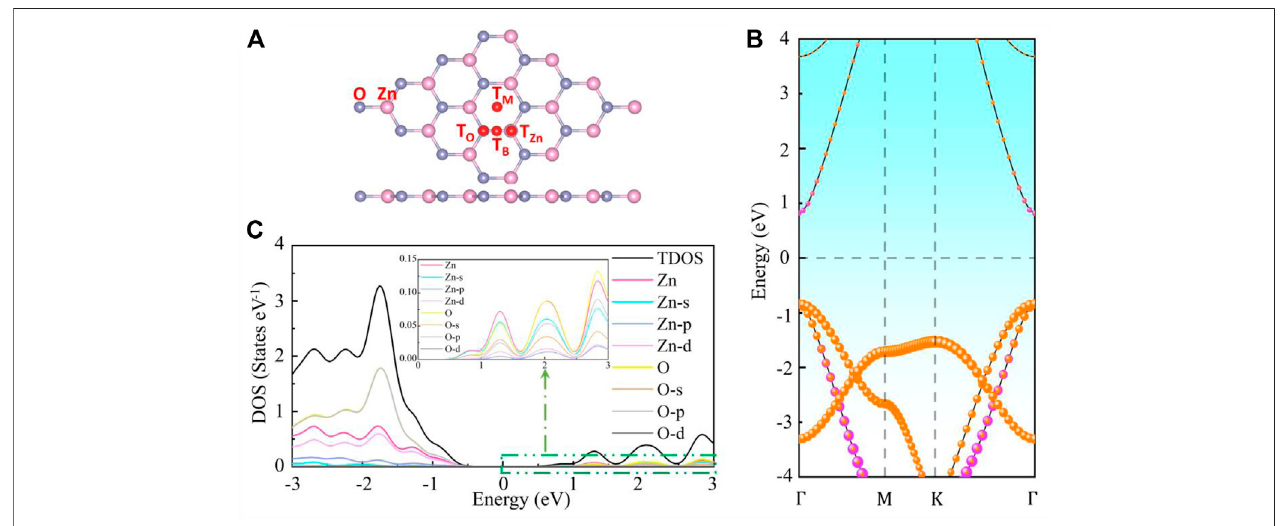
FIGURE 1 | The (A) crystal structure, (B) energy band structure, and (C) density of state of intrinsic g-ZnO.